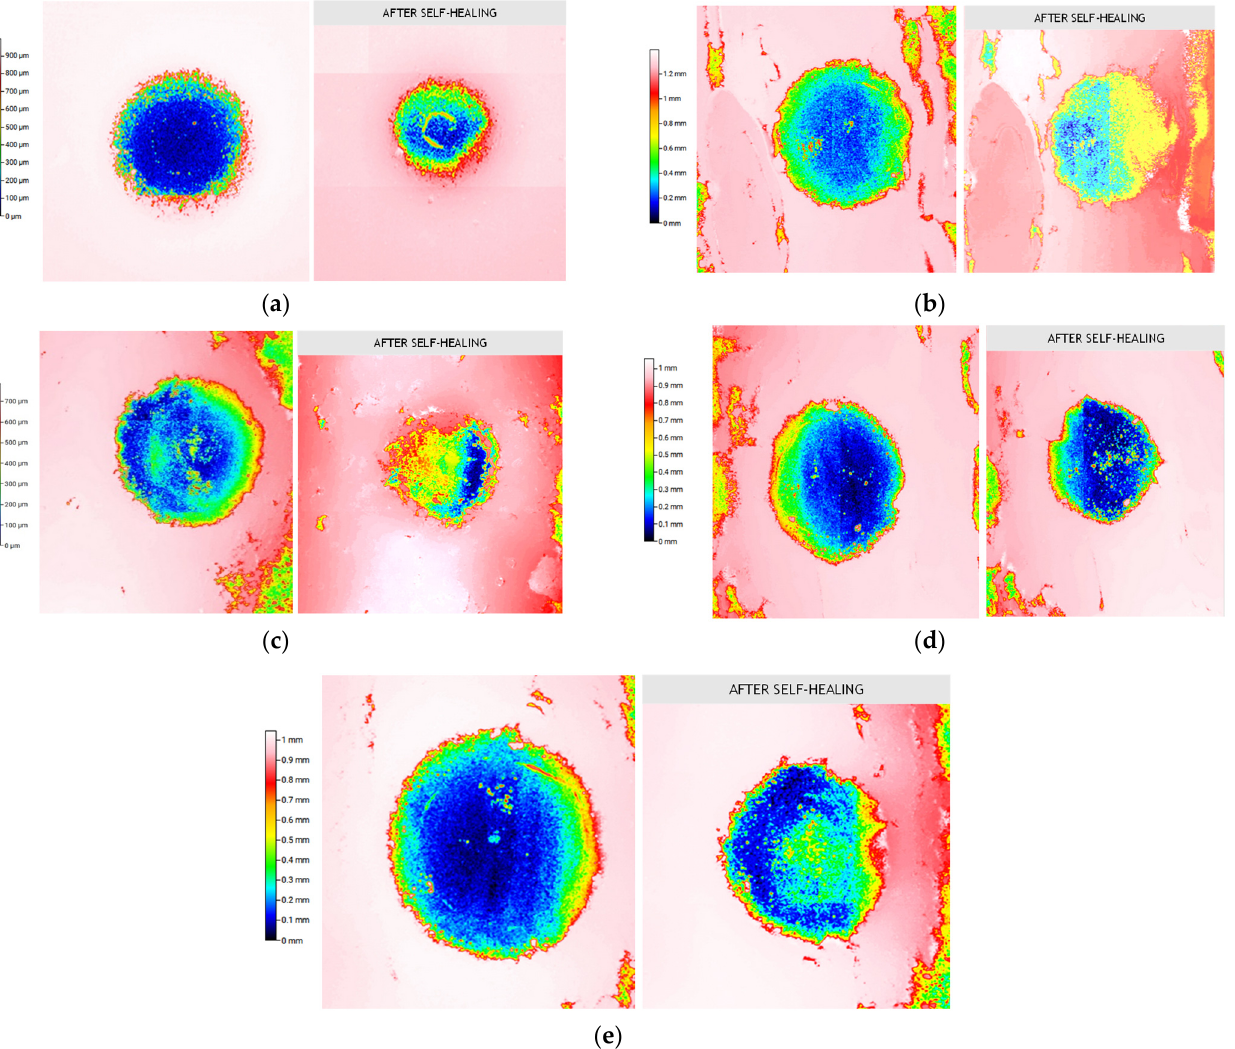
Figure 8. Profilometer micrographs of the ( a ) neat, and reinforced Surlyn with ( b ) 4, ( c ) 5, ( d ) 6, and ( e ) 7 wt.% CNT. The left and right images show the sample before and after self-healing, respec- tively.